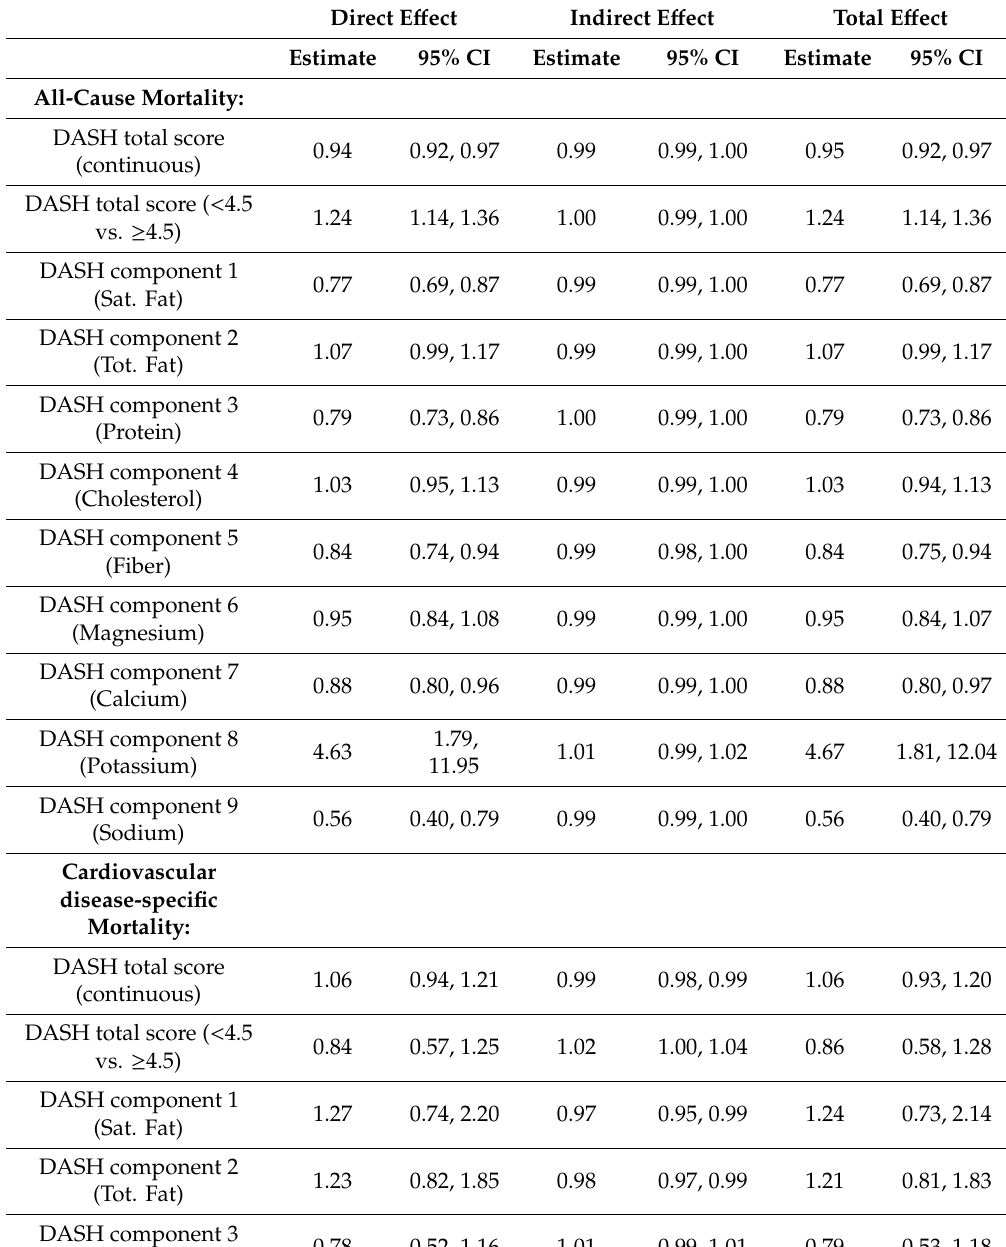
Table 6. Direct, Indirect and Total E ff ects for Mediation of Dietary Approaches to Stop Hypertension Diet-Mortality Relationships by Allostatic Load Index—2001–2010 NHANES *. Direct E ff ect Indirect E ff ect Total E ff ect Estimate 95% CI Estimate 95% CI Estimate 95%